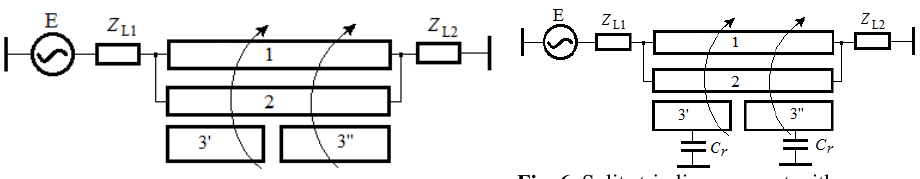
Fig. 6. Split strip line segment with adjustment of parameters by means of lumped elements with capacity